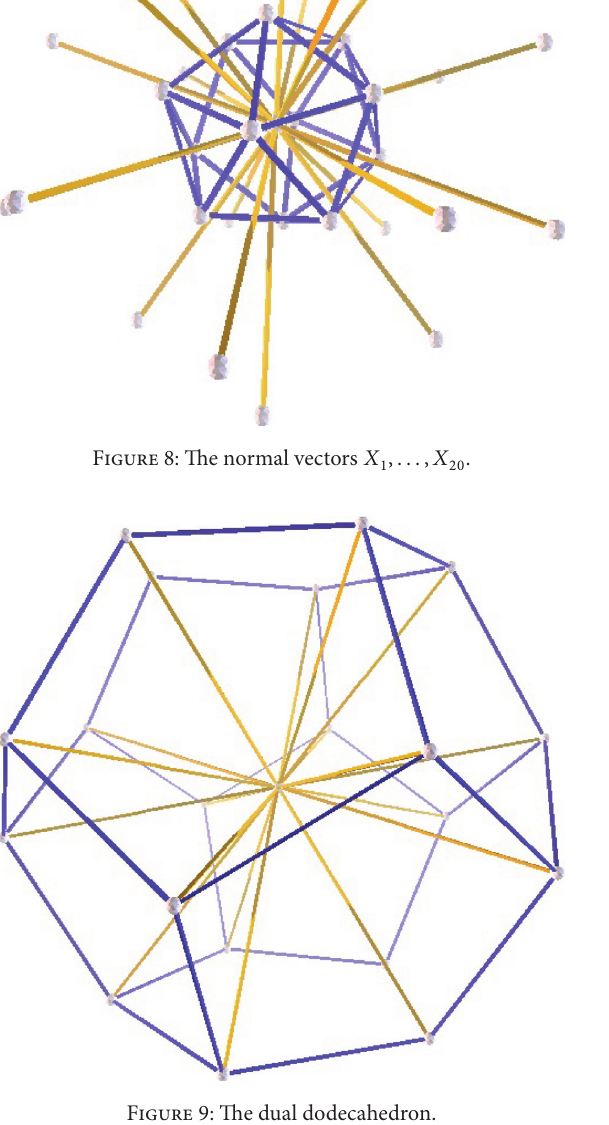
Figure 9: The dual